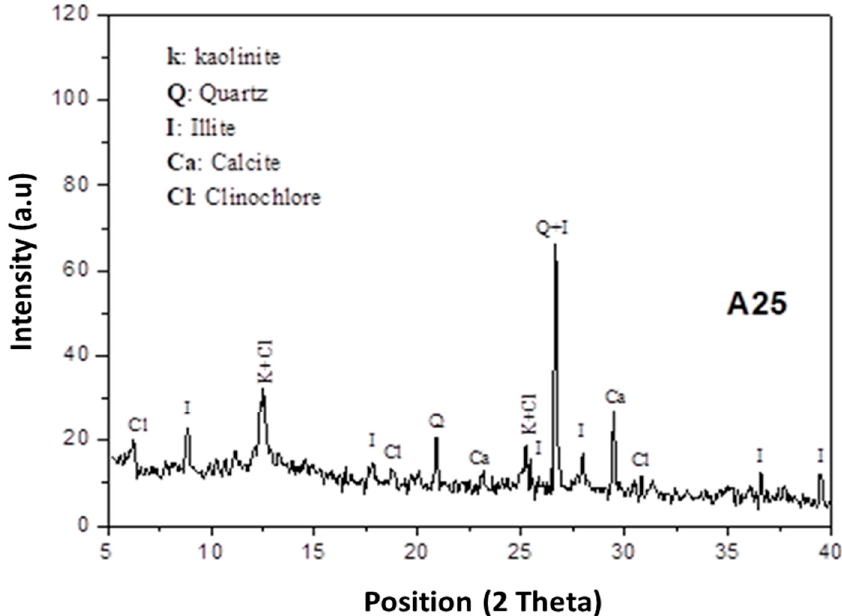
Figure 1. Diffractograms of A25 sample with K—Kaolinite (00-003-0058), Q—Quartz (01-082-0511), I—Illite (00-026-0911), Ca—Calcite (00-002-0629), Cl—Clinochlore (00-029-0701) .